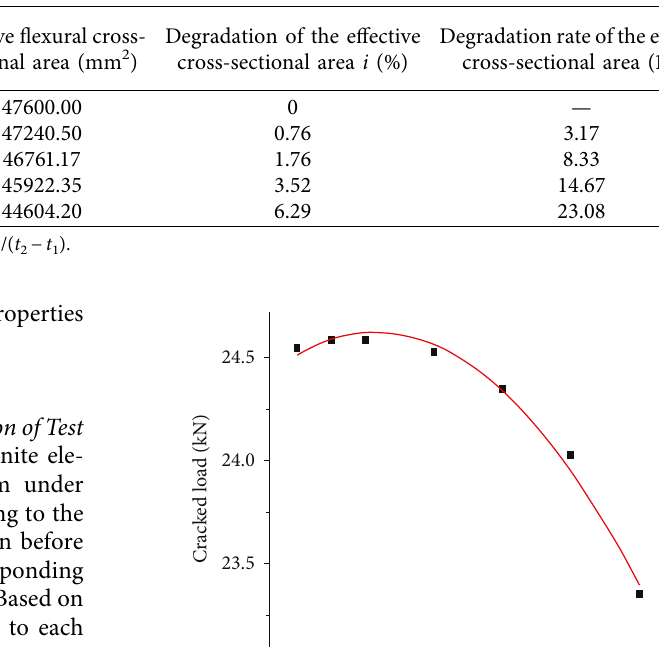
Table 5: Degradation of effective cross-sectional area of flexural section.